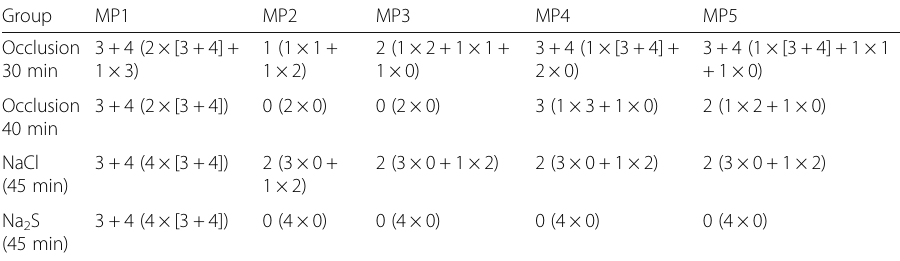
All animals showed normal function before aortic balloon occlusion. During reperfusion, only one animal in the sodium chloride group ( n =4) showed joint movement whereas all other pigs in the sodium sulfide ( n =4) group lost hind motor function. The data of the two groups with 30 min ( n =3) and 40 min ( n =2) occlusion time were obtained in preliminary experiments as described above. See text for details on the scoring